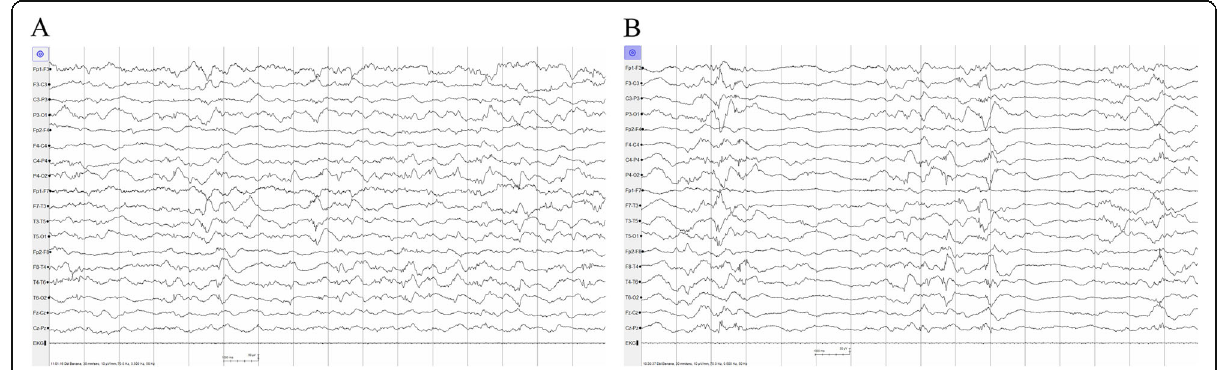
Fig. 2 Electroencephalogram: a : abnormal background activity with diffuse low and moderate amplitude slow activity of 1.5-2 Hz. b the posterior head was dominated by frequent multi-focal sharp wave, spike wave, and slow spike wave, with medium voltage suppression of 1 – 2